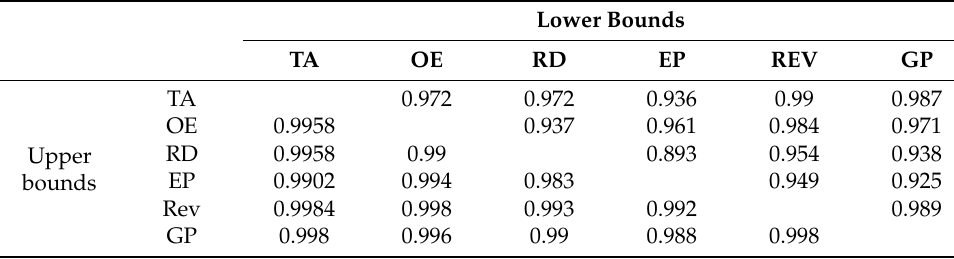
Table 5. Lower/upper bounds of Fisher 95% confidence for the correlation